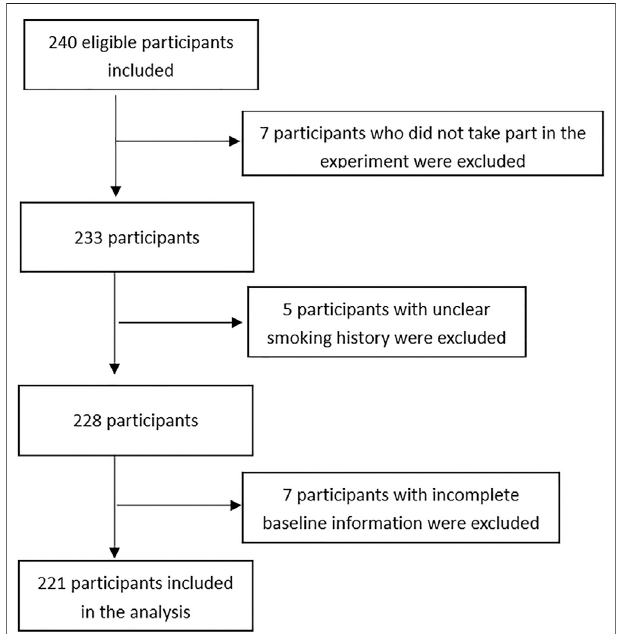
FIGURE 1 | Describes selection process of the study